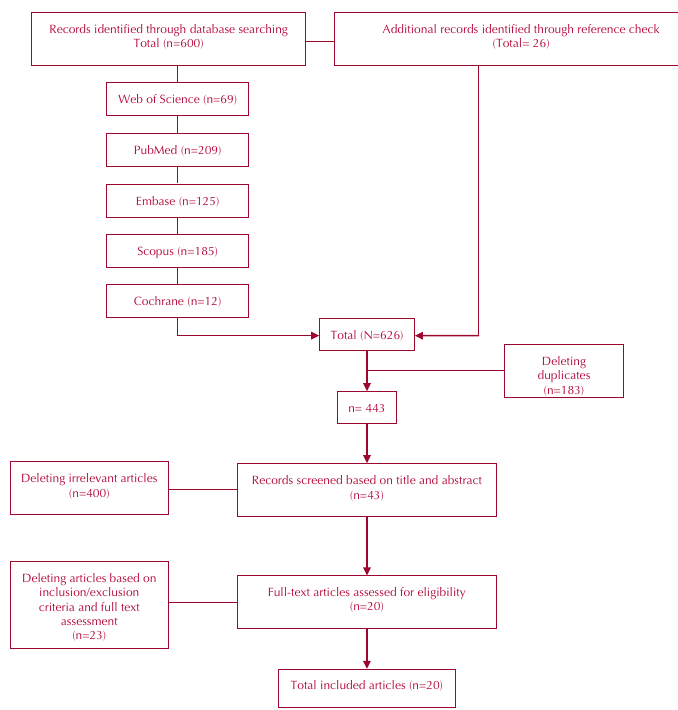
Figure 1. Flow-chart depicting the literature search and study selection